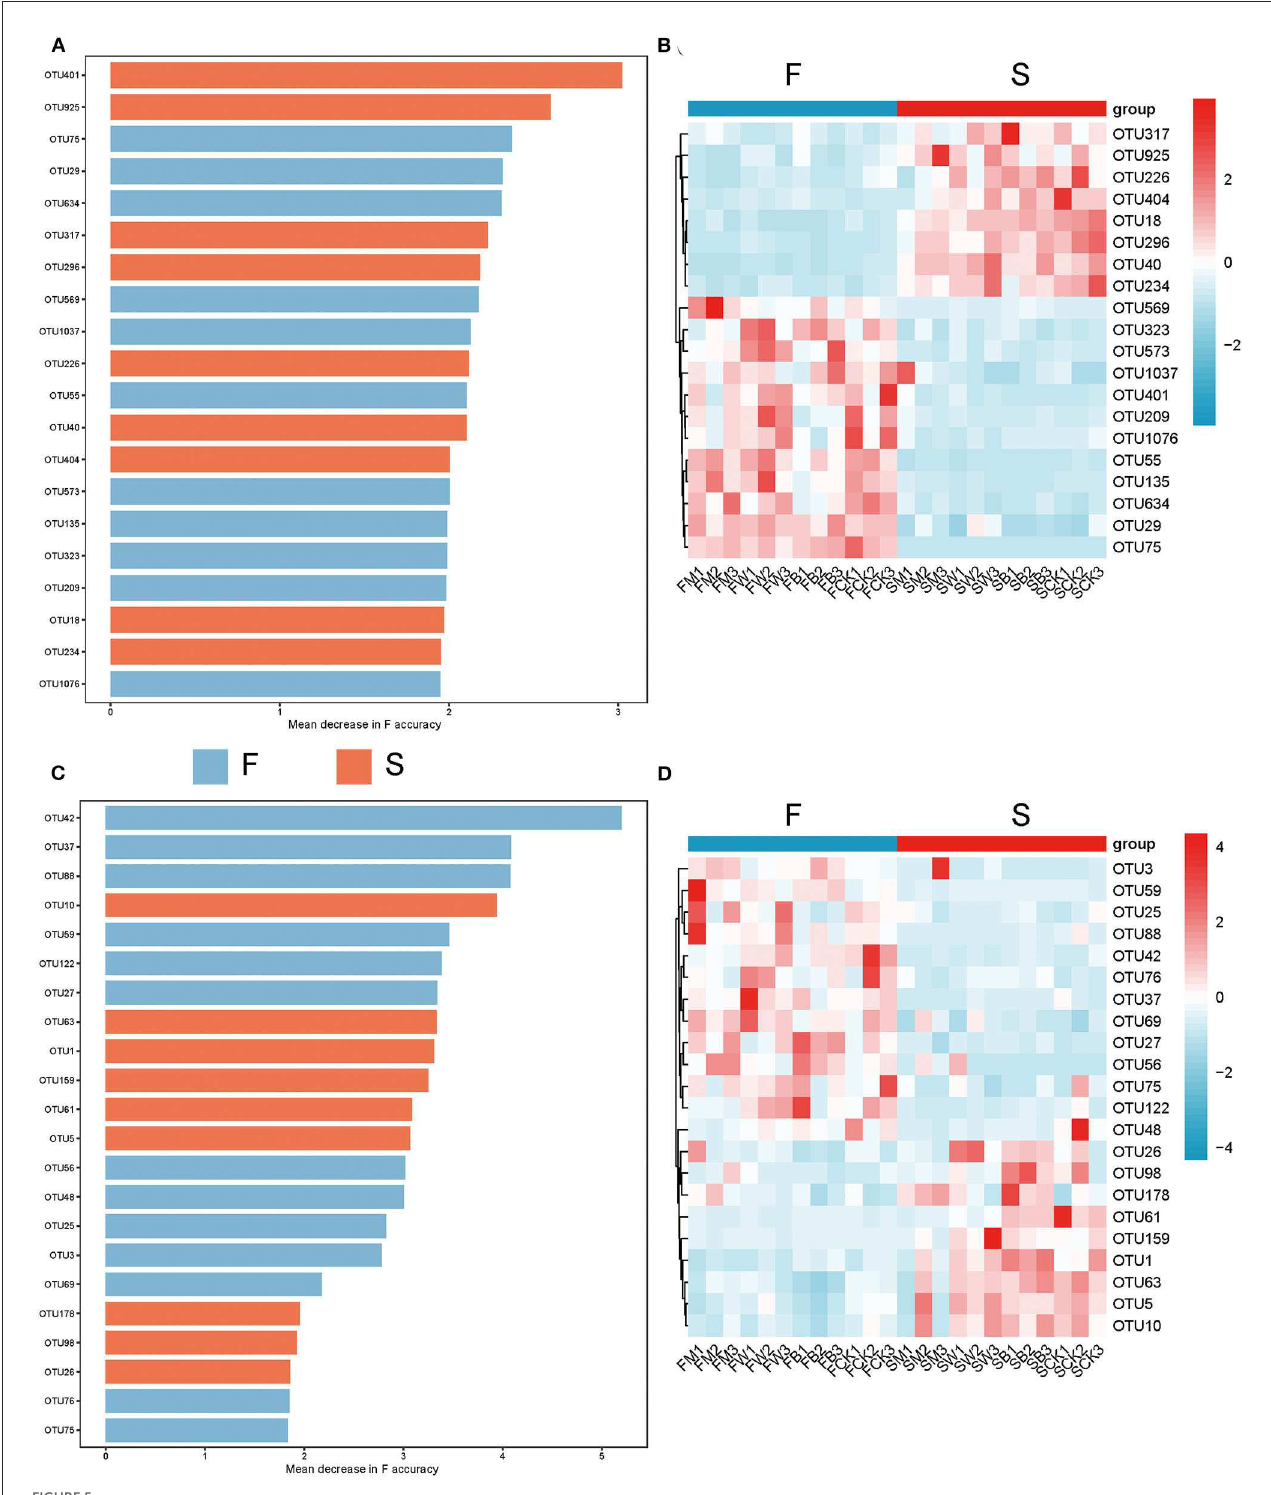
FIGURE5 Microbes with the best identification ability screened from random forests under different straw-returning modes. (A, B) The 20 most discriminant genera in the models classifying the F and S group bacterial microorganisms at the genus level. The bar lengths indicate the importance of the variable, and the colors represent enrichment in F (green shades) or S (red shades). (C, D) The 22 most discriminant genera in the models classifying the F and S group fungal microorganisms at the genus level. The bar lengths indicate the importance of the variable and the colors represent enrichment in F (green shade) or S (red